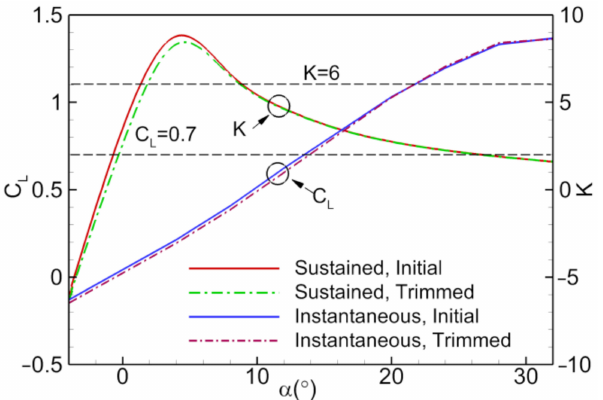
Figure 35. Aerodynamic characteristic of the trimmed configurations at maneuvering state. Sus- tained turn state: H = 5 km, Ma = 0.9; Instantaneous turn state: H = 5 km, Ma = 0.6. α = − 4 ◦ ∼ 32 ◦ , ∆ α = 4 ◦